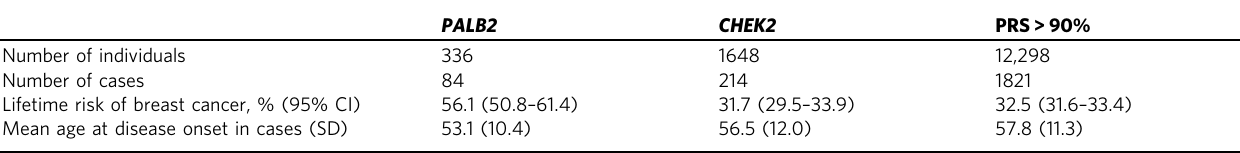
Lifetimeriskwasestimatedbyage80.Thevariants werers180177102(c.1592delT)for PALB2 andrs555607708(c.1100delC)for CHEK2 .The PALB2 analysiswasdonein109,371women,andthe CHEK2 and PRS analyses in 122,978 women. CI con fi dence interval, SD standard